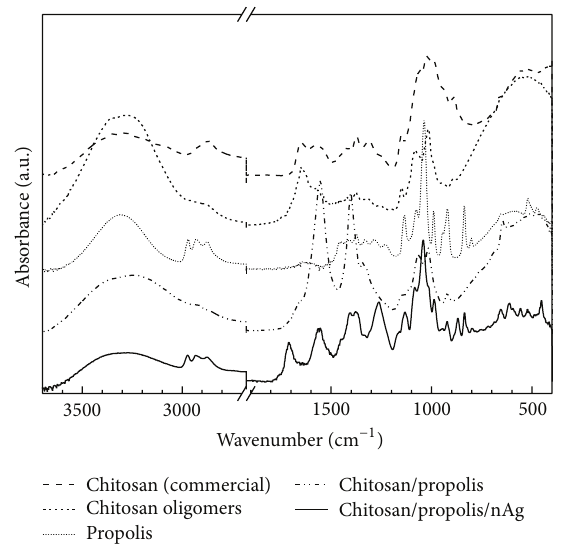
Figure 1: ATR-FTIR spectra of the chitosan- and propolis-based materials under study.